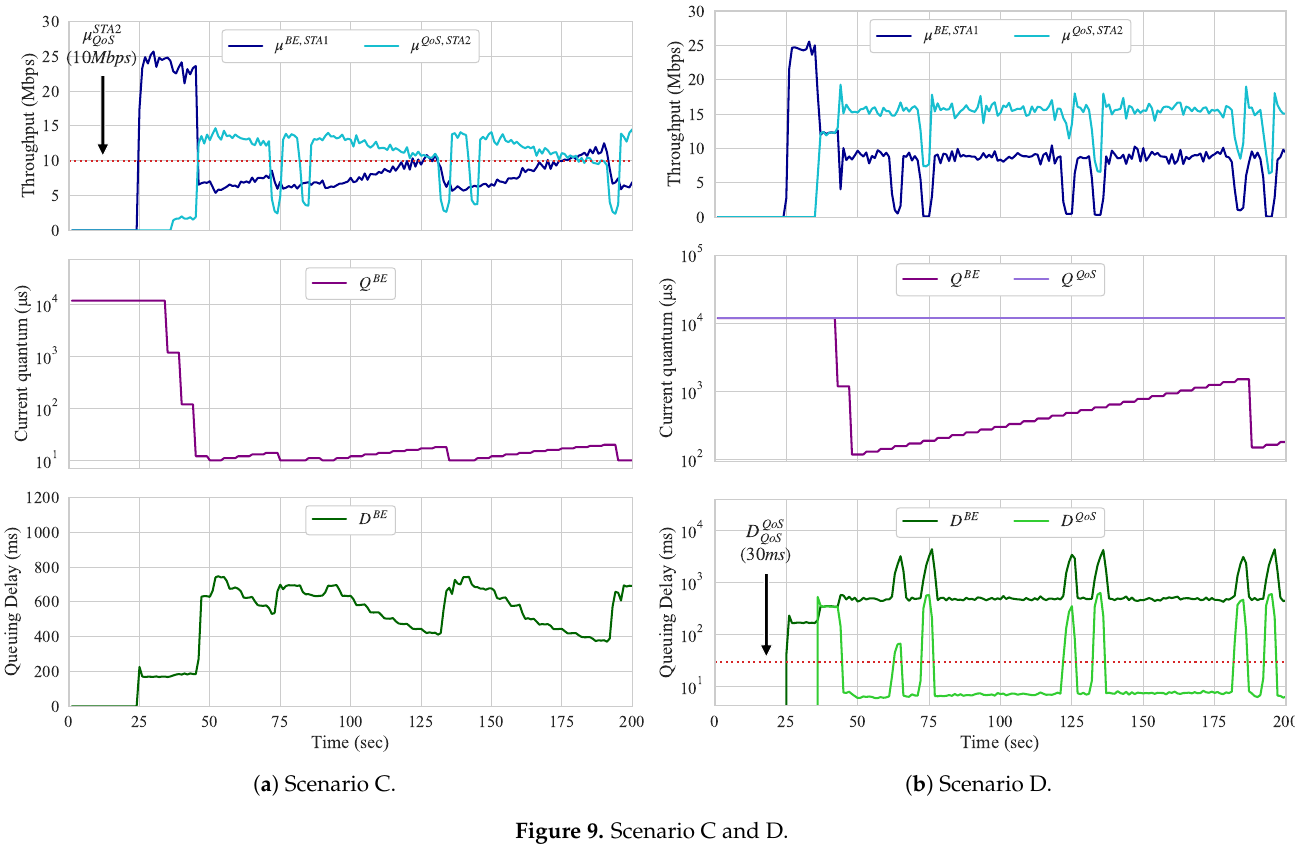
Figure 9. Scenario C and